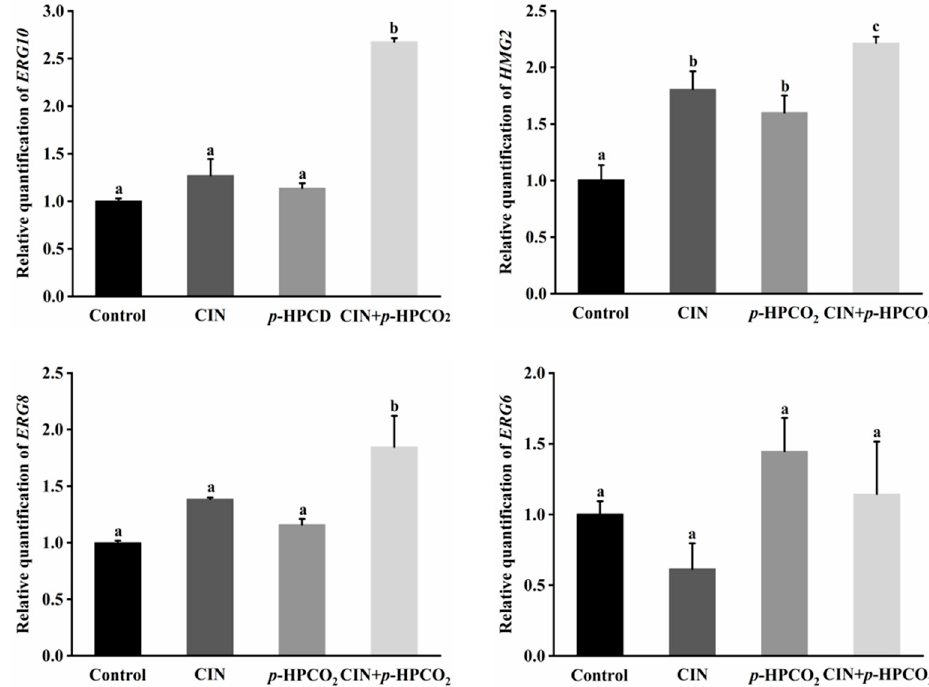
Figure 7. Relative expression of genes involved in ergosterol biosynthesis in Saccharomyces cerevisiae treated with individual and combined cinnamon oil (CIN) (0.02%) and petit -high pressure CO 2 ( p -HPCO 2 ) (1.3 MPa) for 2 h at 25 °C. The transcriptional levels are expressed as fold increase or decrease relative to that of the control. The housekeeping gene ACT1 was used as an internal standard. Different letters above bars indicate significant differences ( p < 0.05).